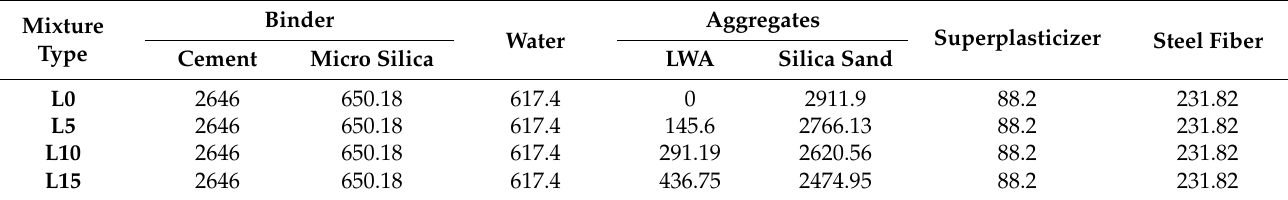
Table 3. Proportions of the mixtures used